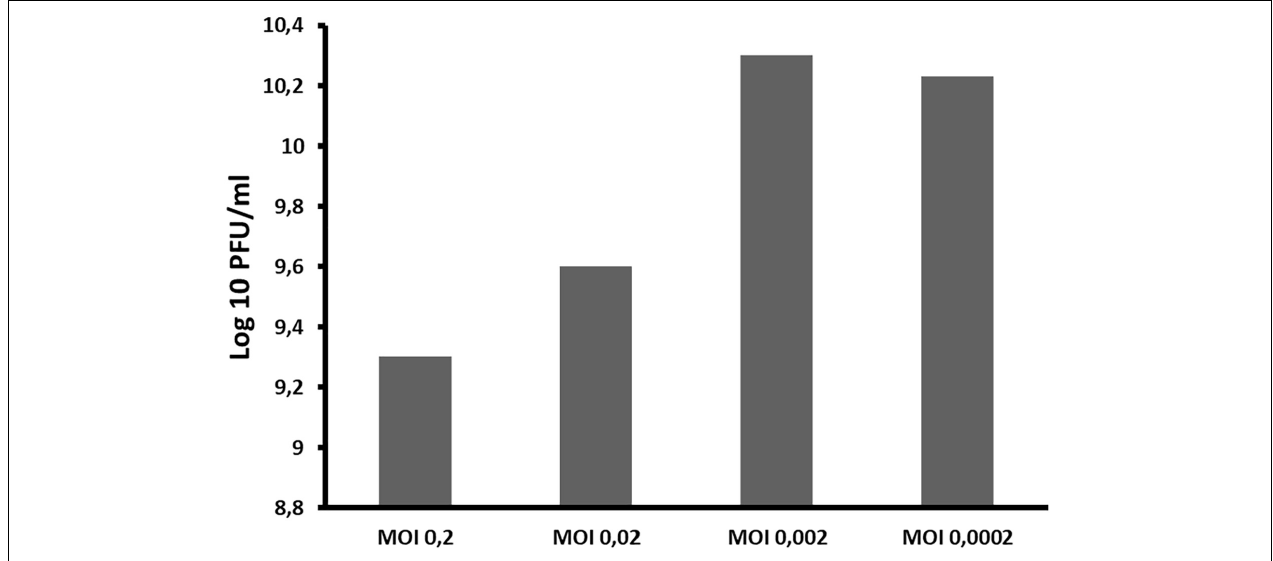
FIGURE 4 | The influence of different ratios of bacteriophages and bacteria in suspension (MOI) during phage ACF1 multiplication.